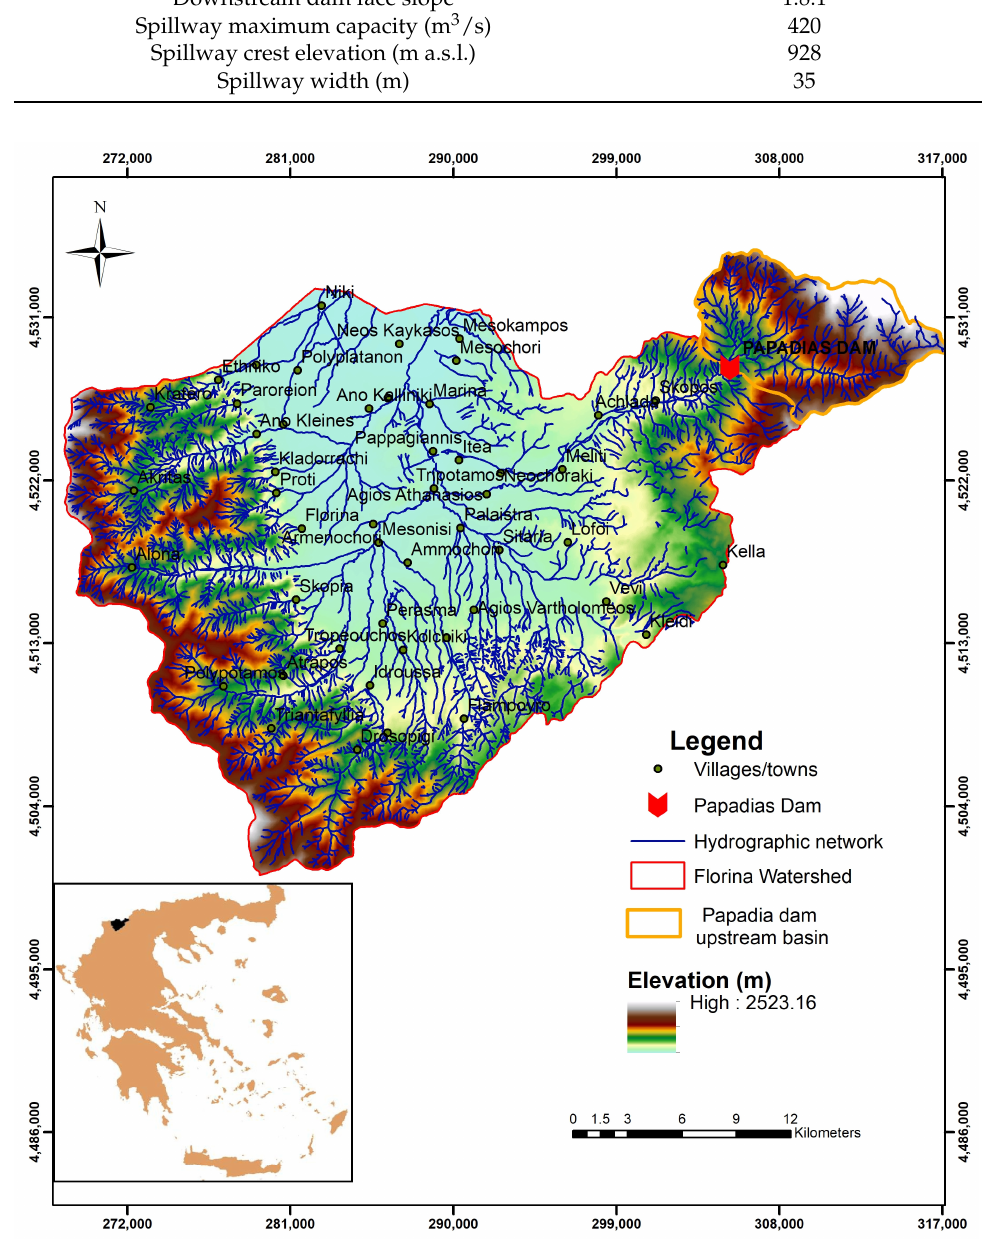
Figure 1. Topographic map of the Florina basin.